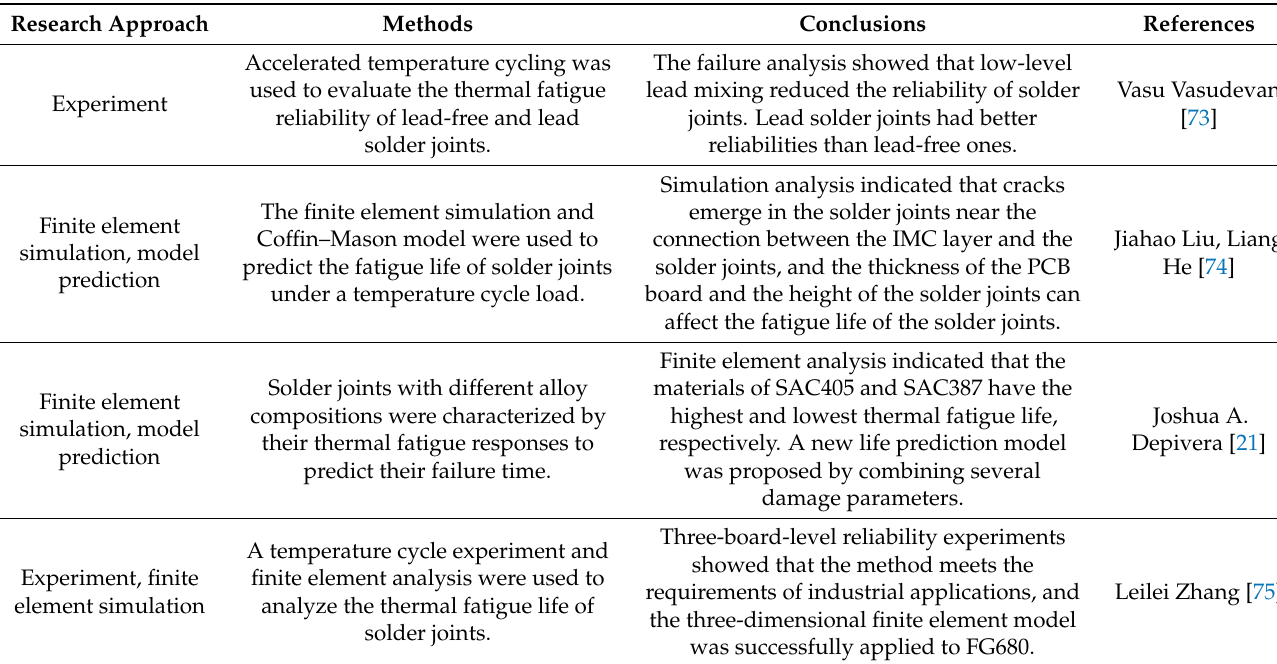
Table 4. Summary of studies conducted under thermal